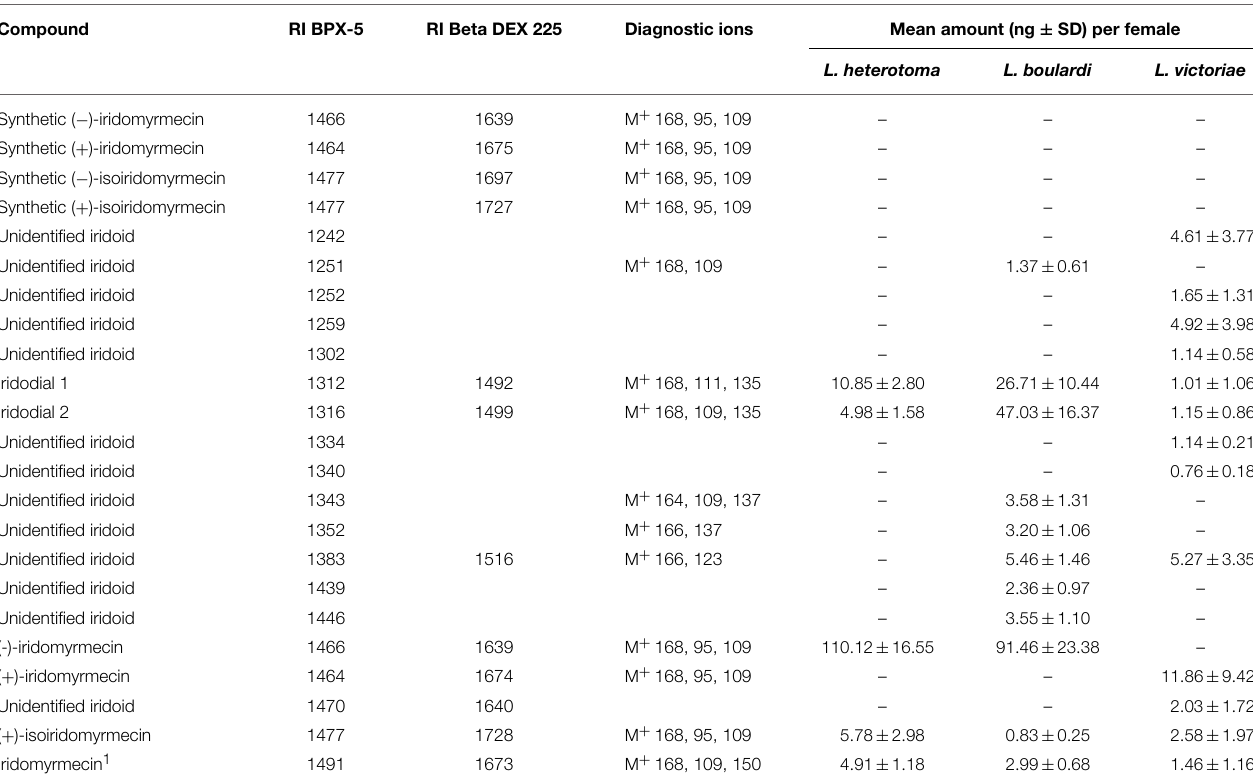
TABLE 2 | Iridoid compounds and amounts thereof found in females of L. heterotoma , L. boulardi , and L. victoriae .